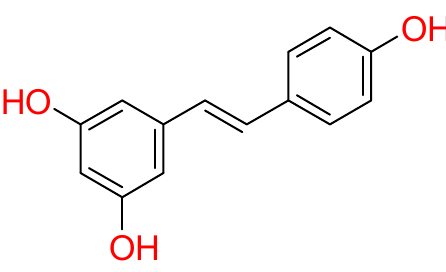
Figure 5. 2D structure of resveratrol.